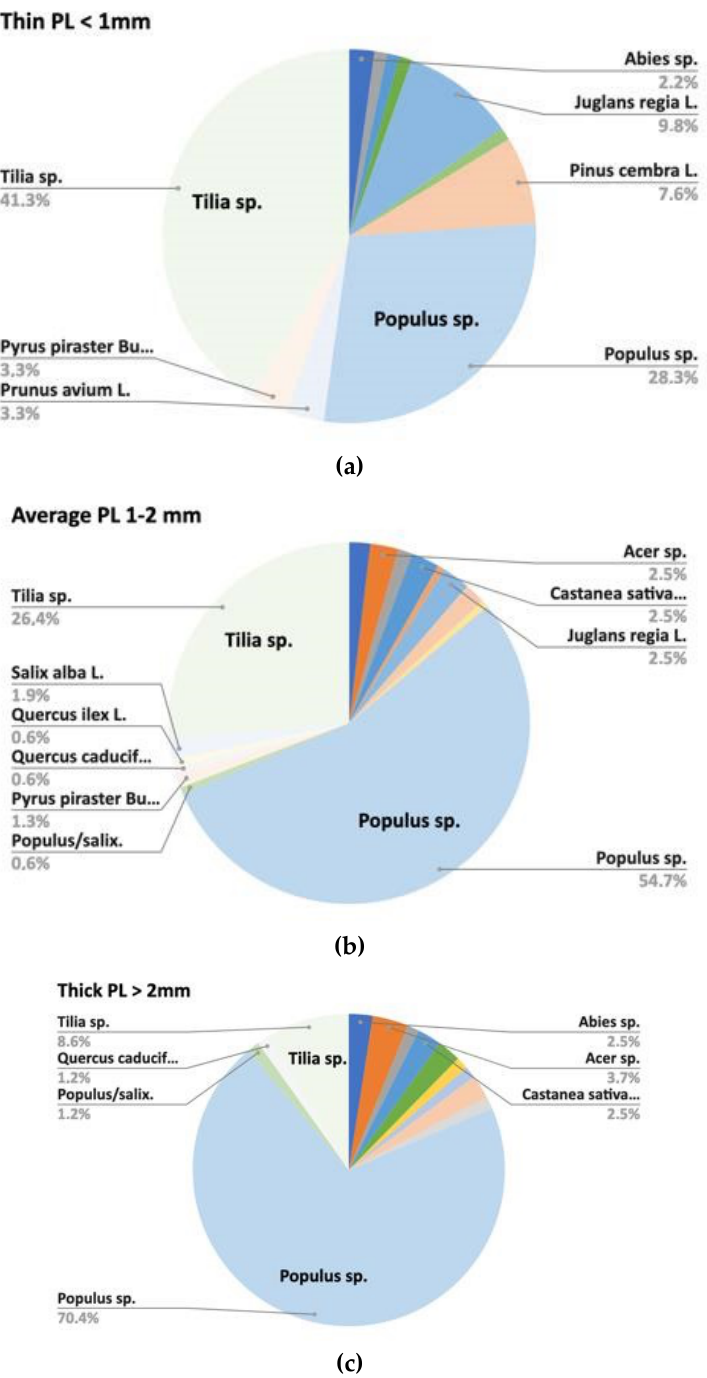
Figure 10. Distribution of timbers based on grades of preparatory layer thickness (a: Preparatory layer thin; b: preparatory layer 1-2 mm; c: preparatory layer thick). layer thin; ( b ): preparatory layer 1–2 mm; ( c ): preparatory layer